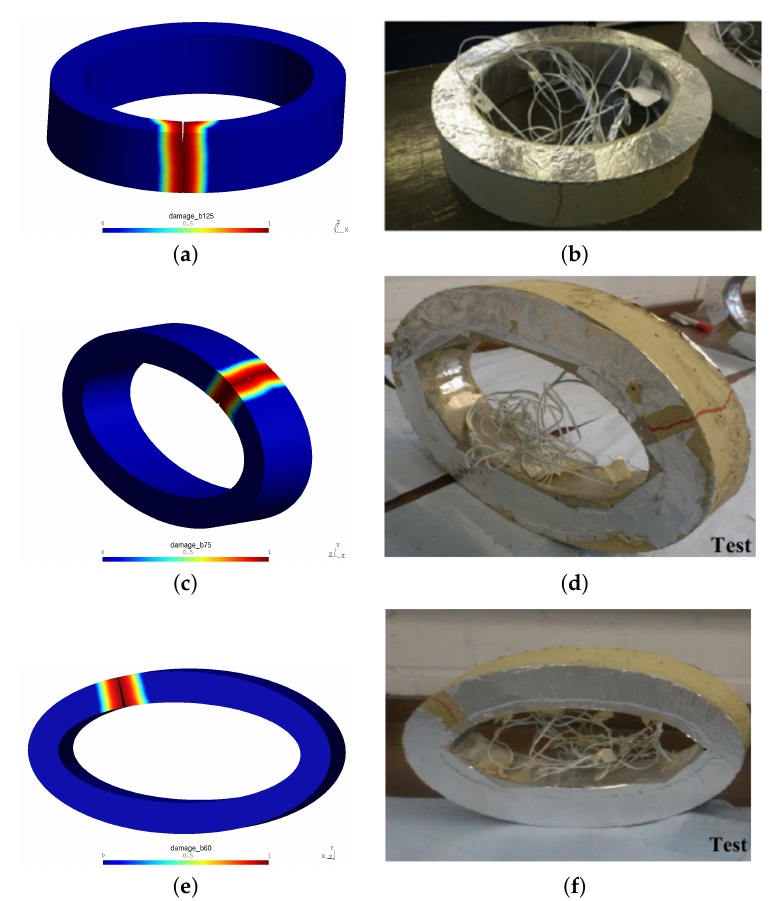
Figure 7. Numerical results issued from the TLS model (on the left) versus experimental results from [18,27] (on the right) for a = 2.5; ( f ) ( e ) b